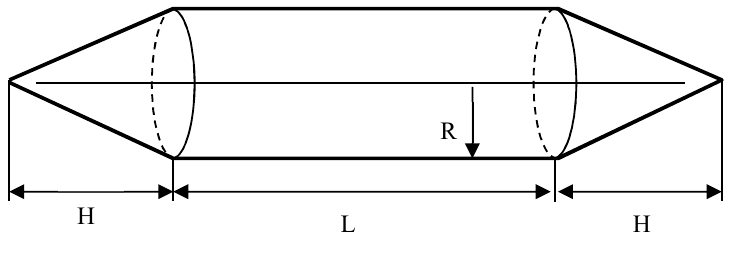
Figure 14. Geometrical dimensions of a submarine.